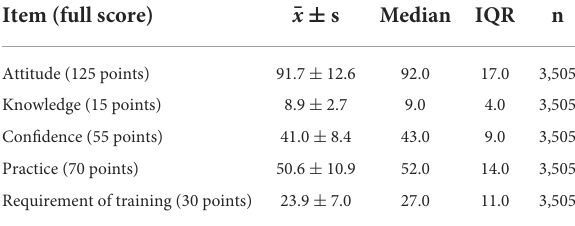
TABLE 1 Characteristics of study participants ( n = 3505). TABLE 2 Measure data of studied participants ( n = 3,505).